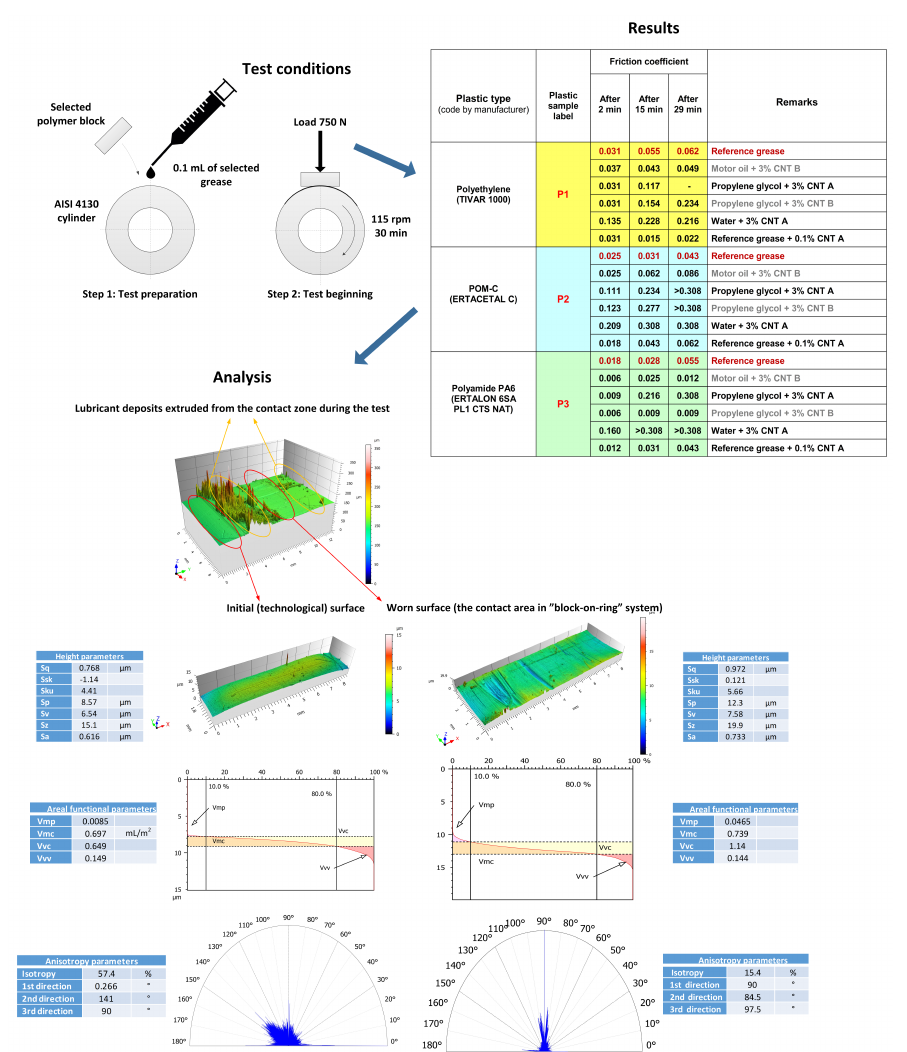
Figure 5. Design and results of the first, “block-on-ring” tribometer experiment (roughness nomen- clature: Sa (average roughness), Sq (root-mean-squared roughness), Sp (max peak height), Sv (max valley depth), Sz (max height of surface), Vmp (peak material volume), Vmc (core material volume), Vvc (core void material), Vvv (valley void